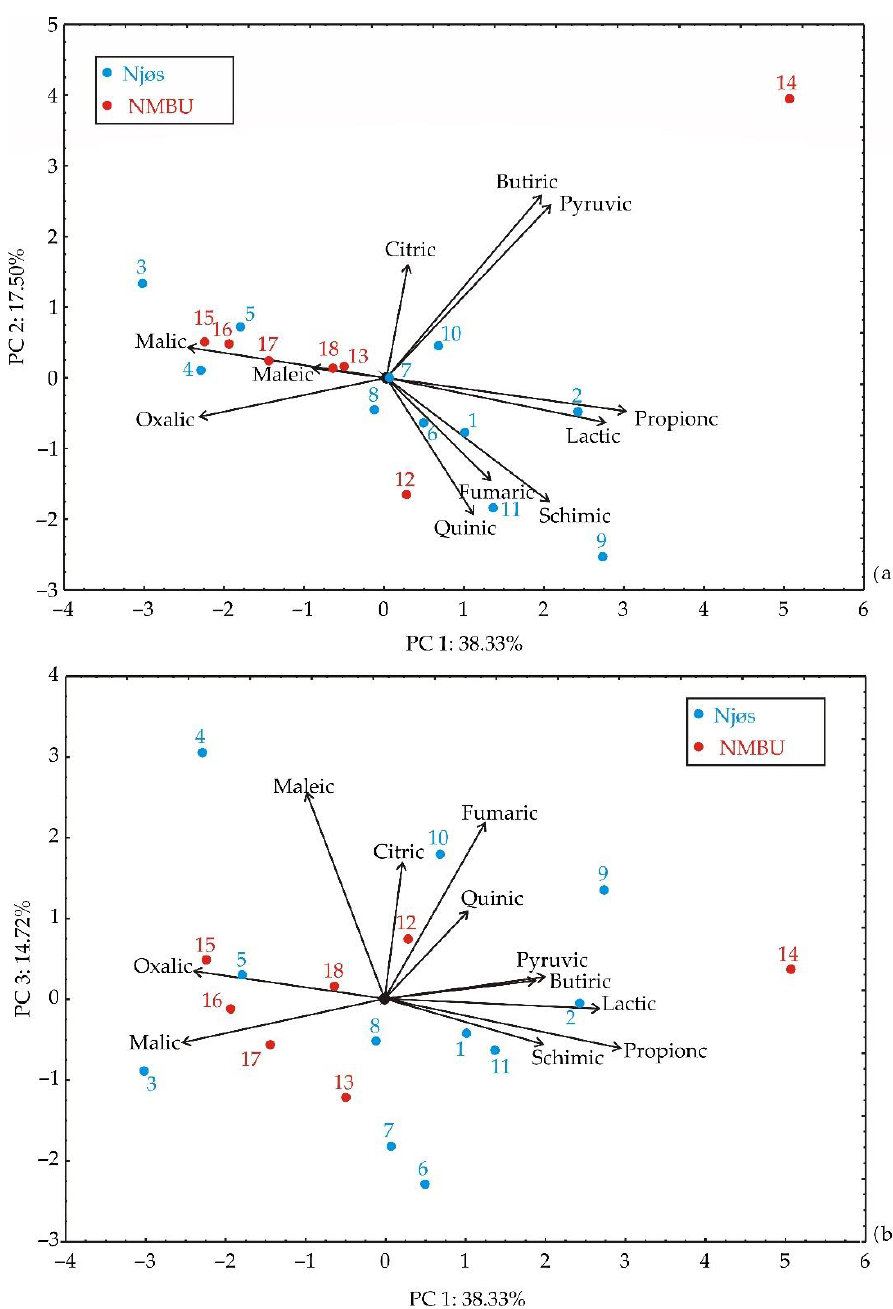
Figure 3. PCA ordination of fruit acid content variables: ( a ) projection in PC1-PC2 plane; ( b ) projection in PC1-PC3 plane.